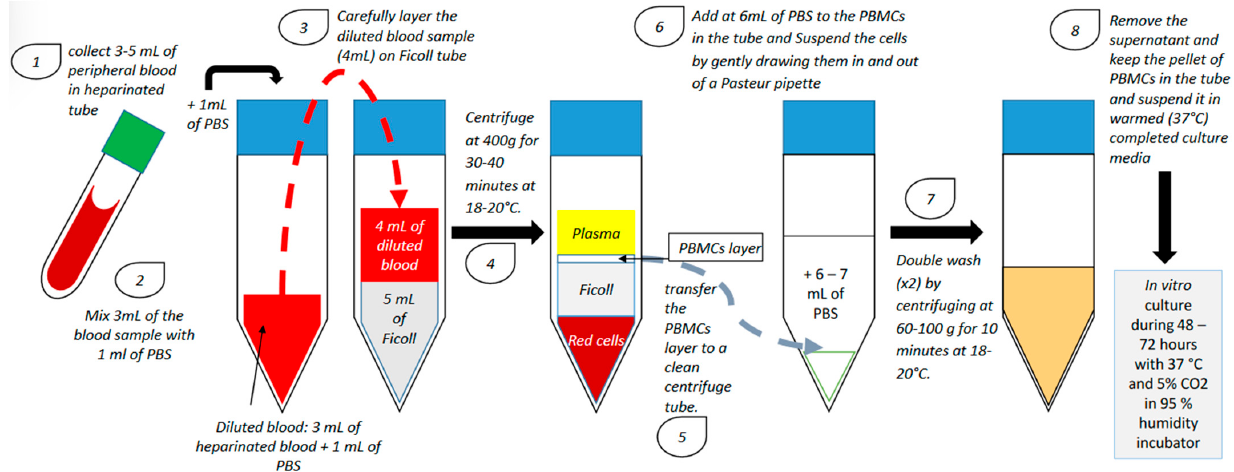
Figure 1. PBMC isolation technique and in vitro culture (PBS: phosphate-buffered saline; PBMC: peripheral blood mononuclear cell).